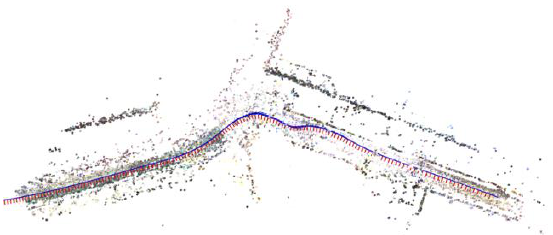
Figure 5. Partial reconstruction of an image based mobile mapping dataset (first 156 images, Cavegn et al., 2016). The approach is able to handle collinear and forward looking camera constellations.